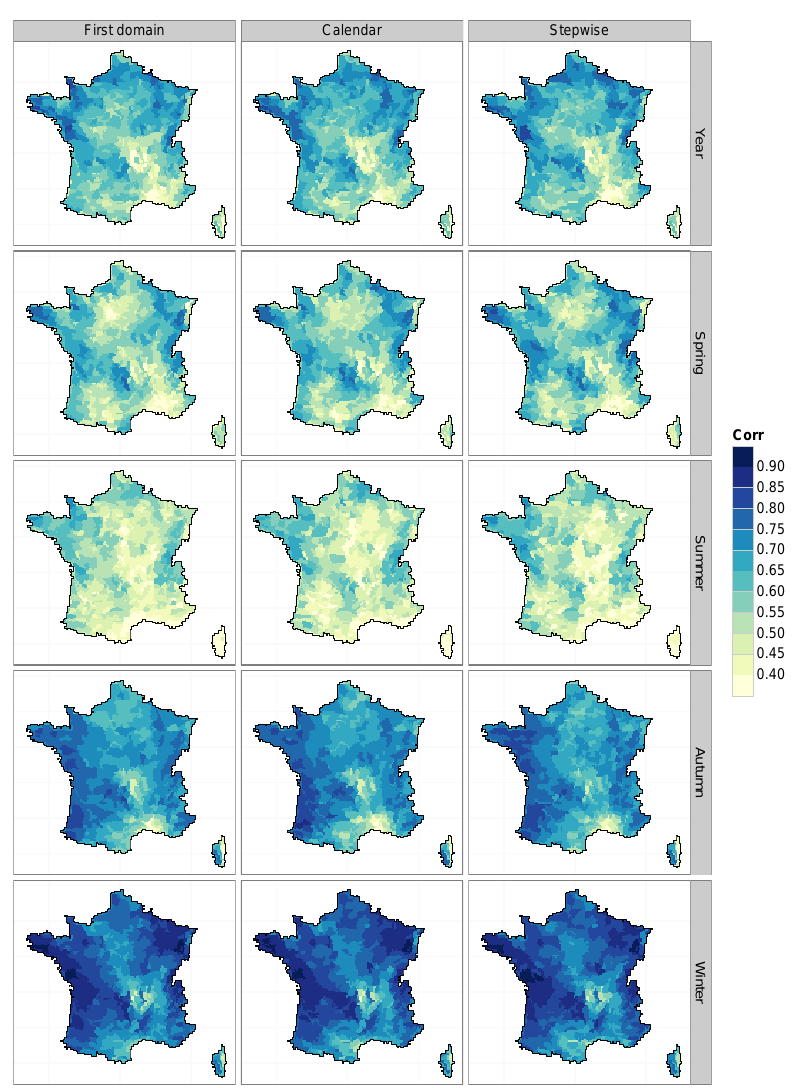
Figure 9. As for Fig. 8, but for precipitation. Minimum value of 0.19 for the first domain selection in summer and maximum value of 0.92 for the first domain selection in